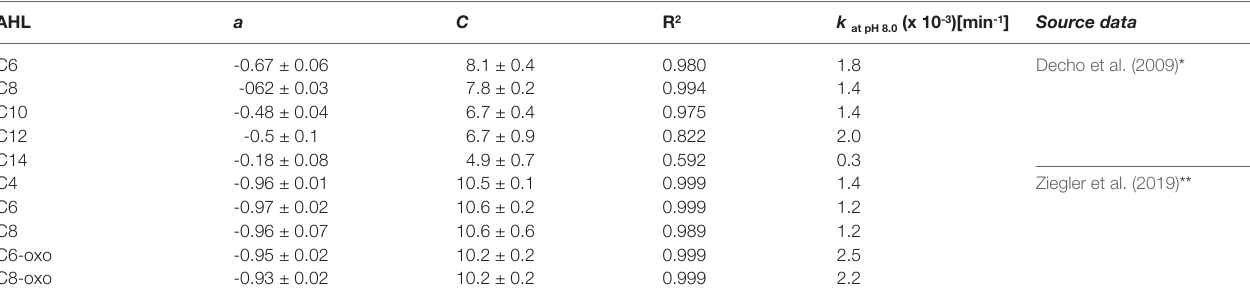
TABLE 1 | Coefficients (± SD) of the relationship between hydrolysis rate k and pH expressed as linear equation of the form -log (k) = a x pH + C, valid for the pH range from 6.0 to 10.0. AHL